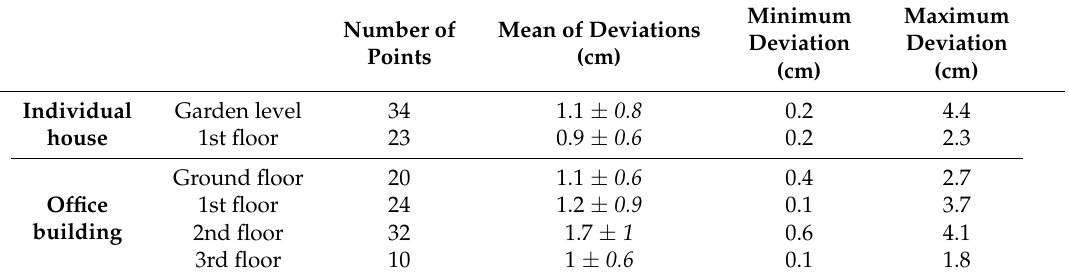
Minimum Maximum Number of Mean of Deviations Deviation Deviation Points (cm) (cm)